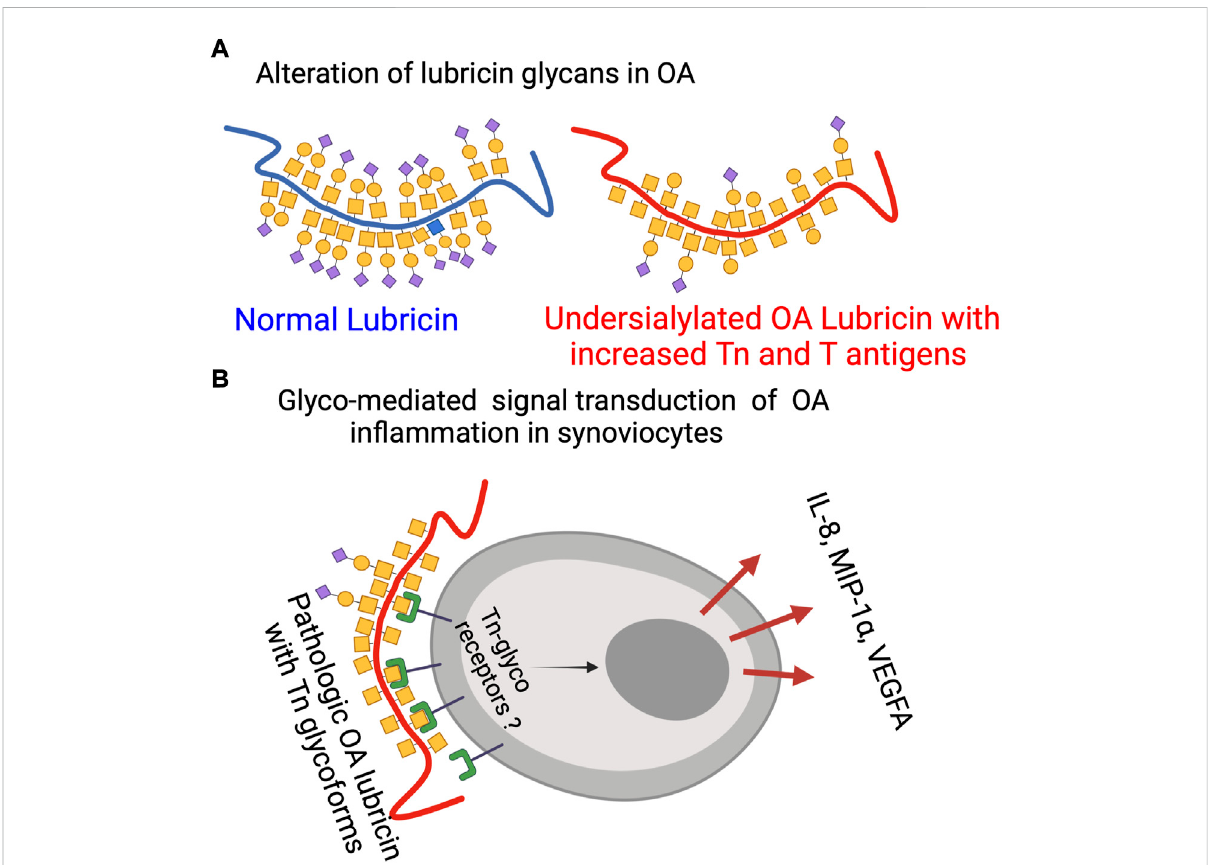
FIGURE 4 Lubricin glycosylationinOA. (A) Schematicrepresentation ofmucin-type lubricinwithitsglycans inOAandinnormal conditionsbasedondata from this report and previous ones (Flowers et al., 2020) (not displaying all of the 172 glycosylation sites of lubricin (Flowers et al., 2020)). (B) Glyco- mediated OA in fl ammation where pathological OA Tn glycoforms of lubricin are interacting with unknown Tn receptors to trigger speci fi c cytokine secretion. The fi gure was made using BioRender